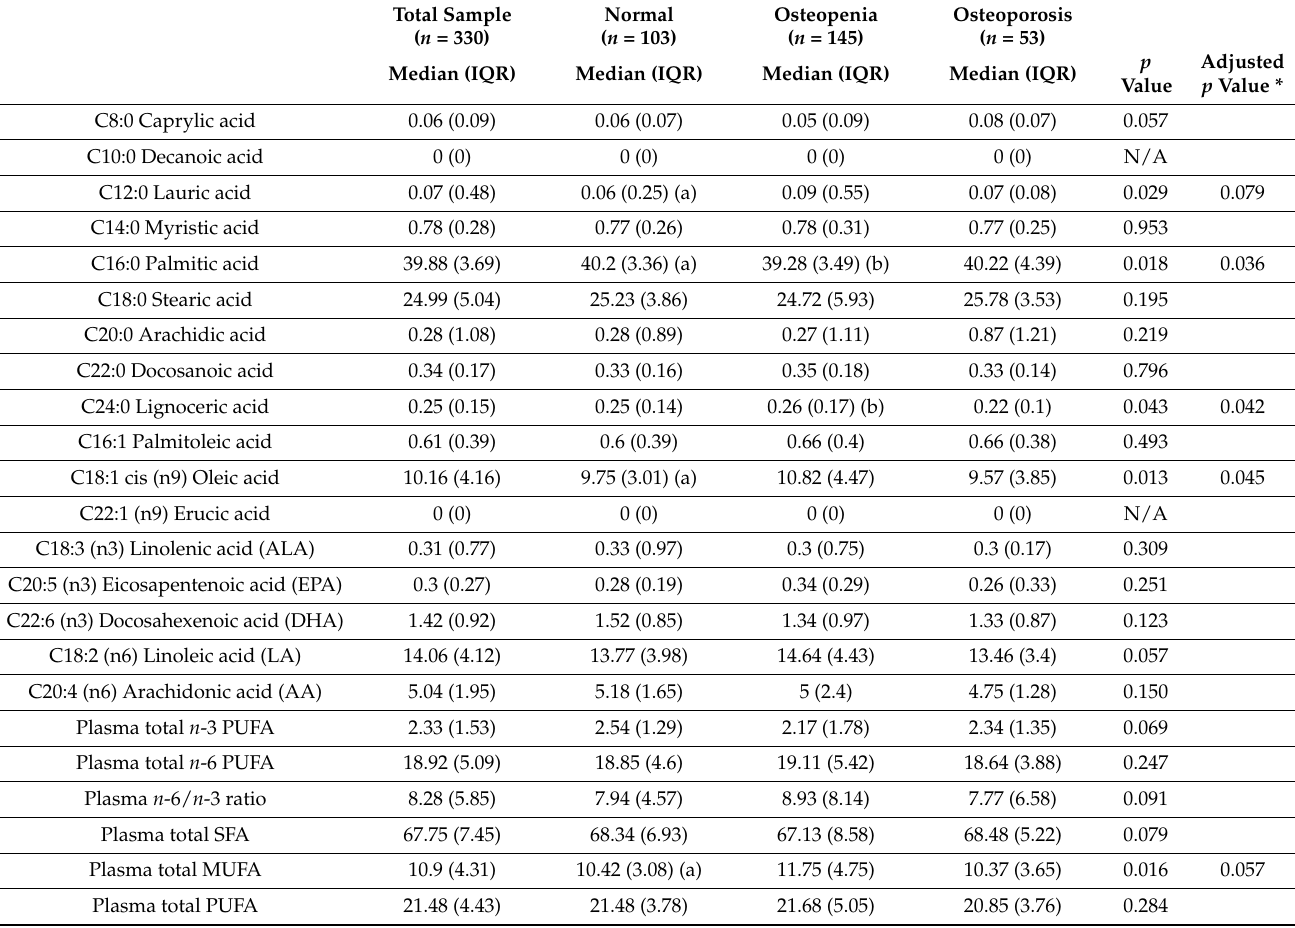
Table 2. Plasma fatty acids profiles (%) in the studied